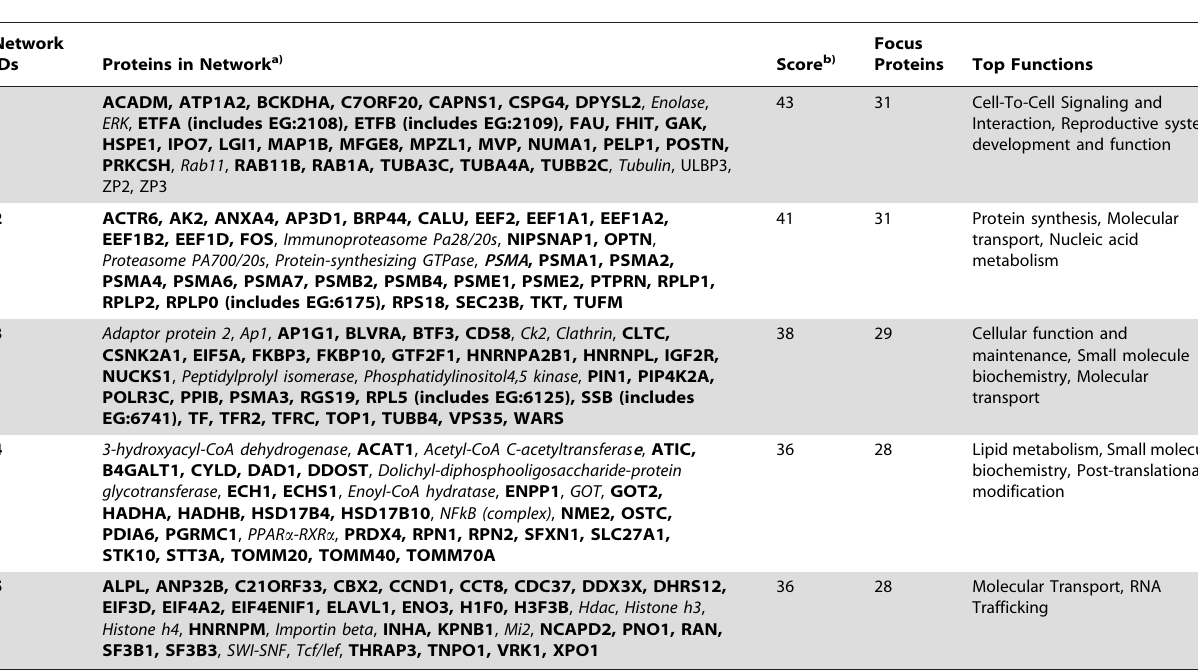
Network IDs Proteins in Network